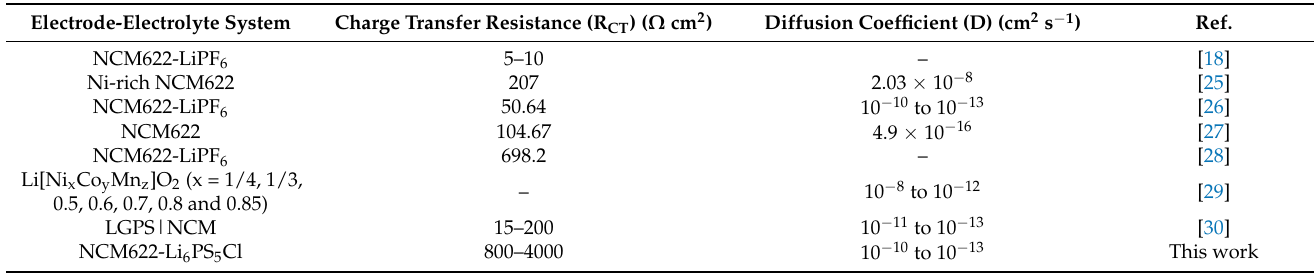
Table 1. The comparative electrochemical properties of previously reported results of NCM electrodes and current results of NCM particles using cavity electrode by pulse